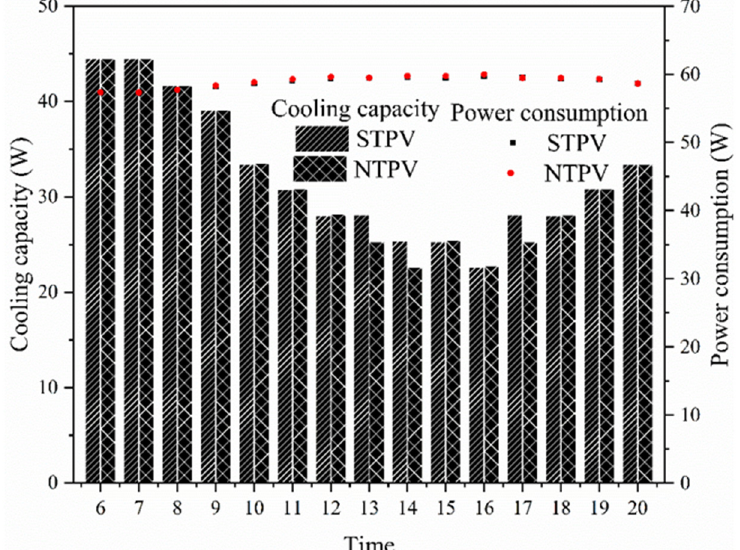
Figure 10. Cooling capacity and power consumption of the system.